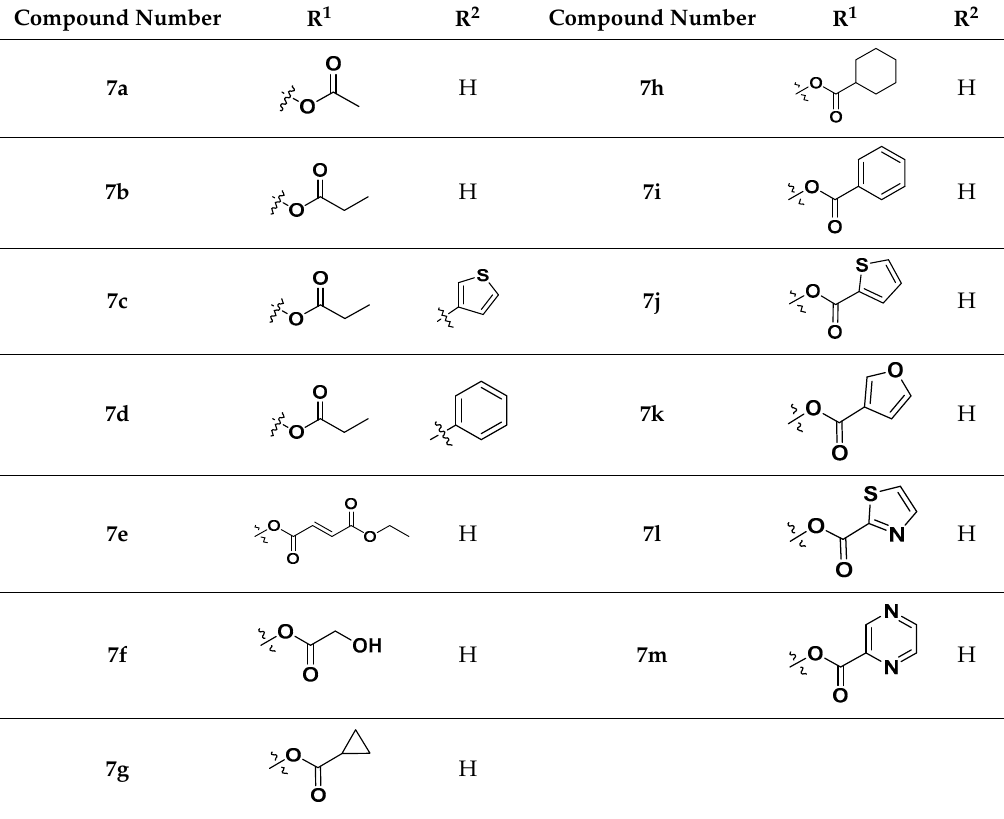
Table 1. Structures of acyloxy derivatives 7a – m.